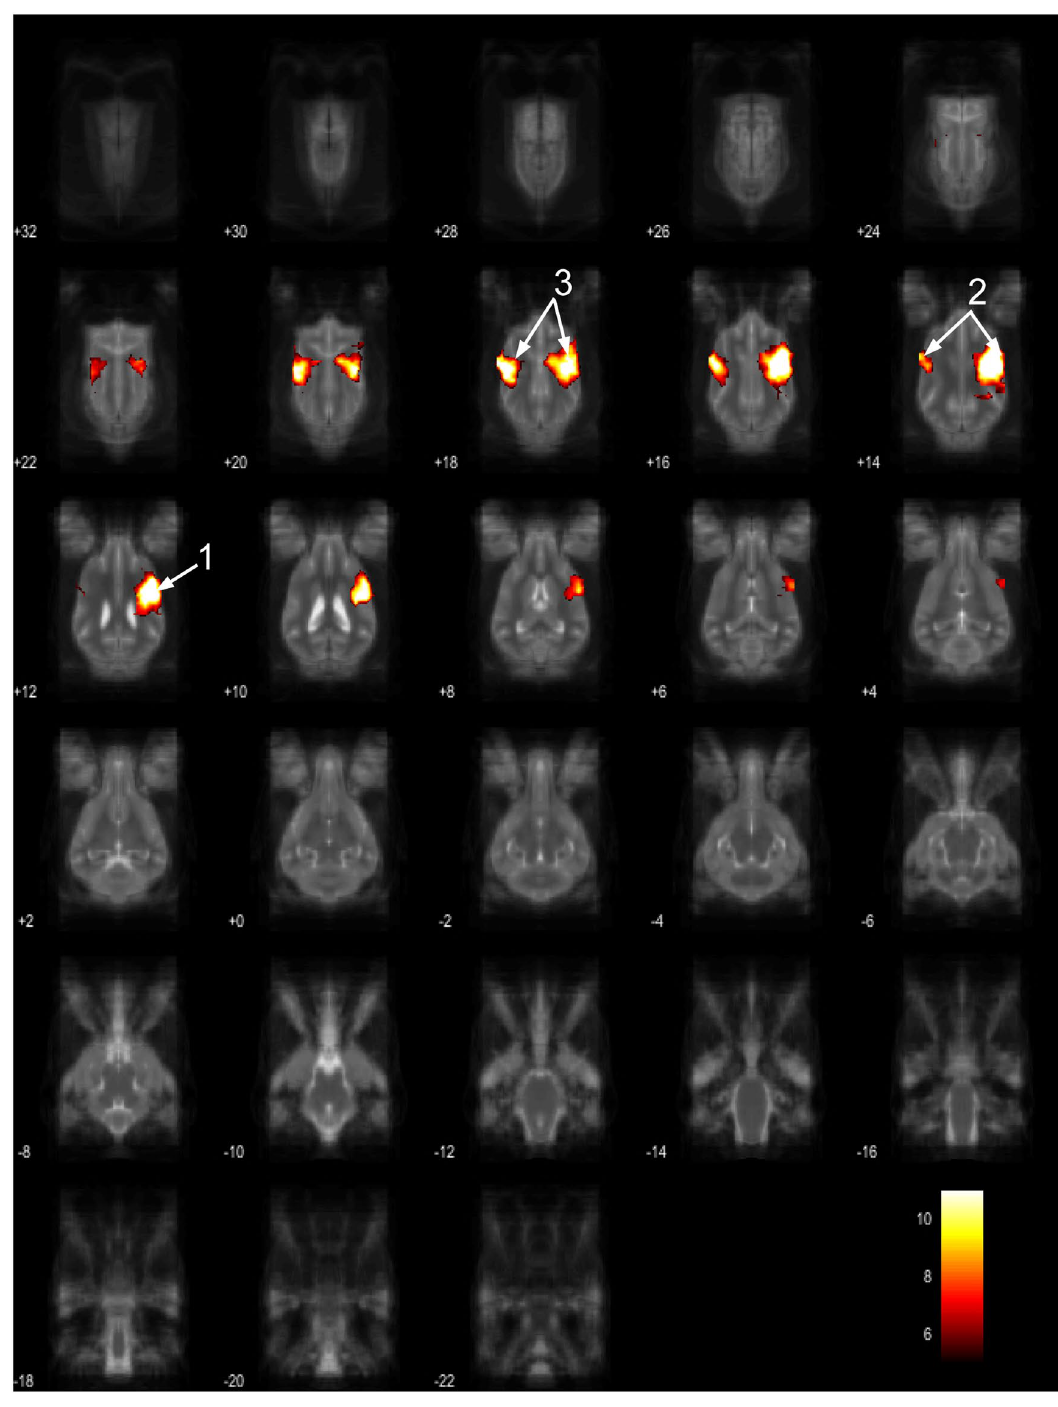
Figure 9. Resting-state network component F from the 15 component gICA. We report the results with a voxel- wise FDR corrected p < 0.001 and cluster treshold of FDR corrected p < 0.005. gICA components are presented as thresholded T-maps, corrected for multiple comparisons, overlaid on the Nitzsche atlas 15 . 1. sensorimotoric cortex, 2. bilateral rostral ectosylvian gyrus, 3. rostral suprasylvian